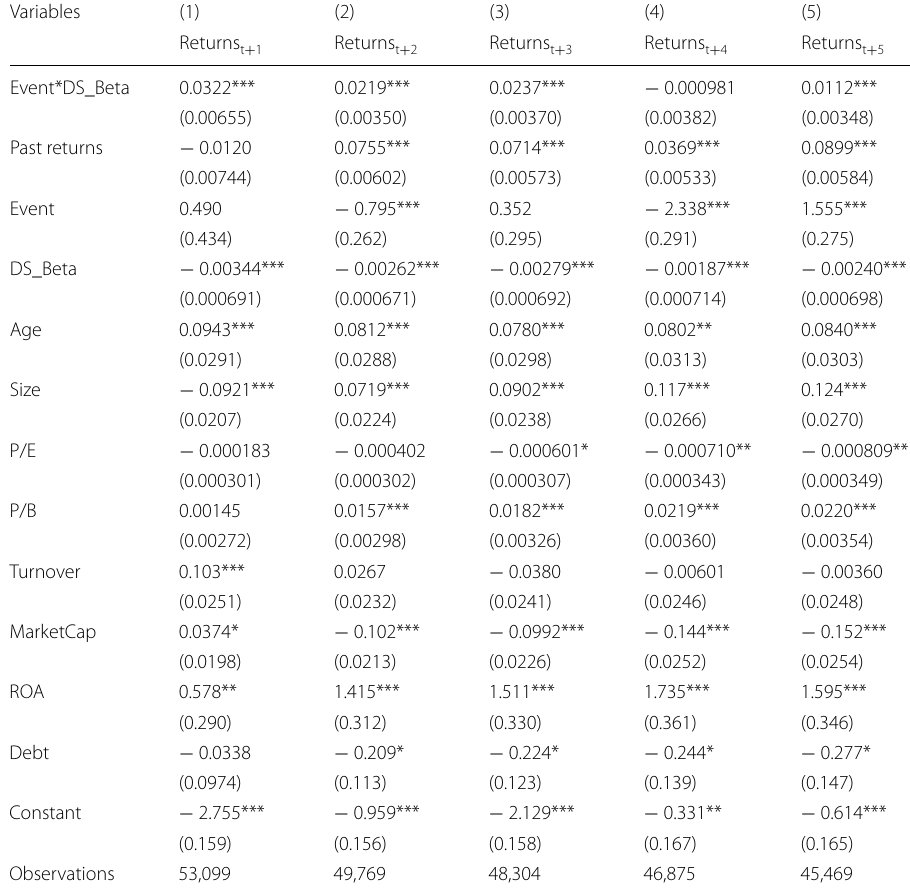
Table 3 Light a lamp, downside risk and